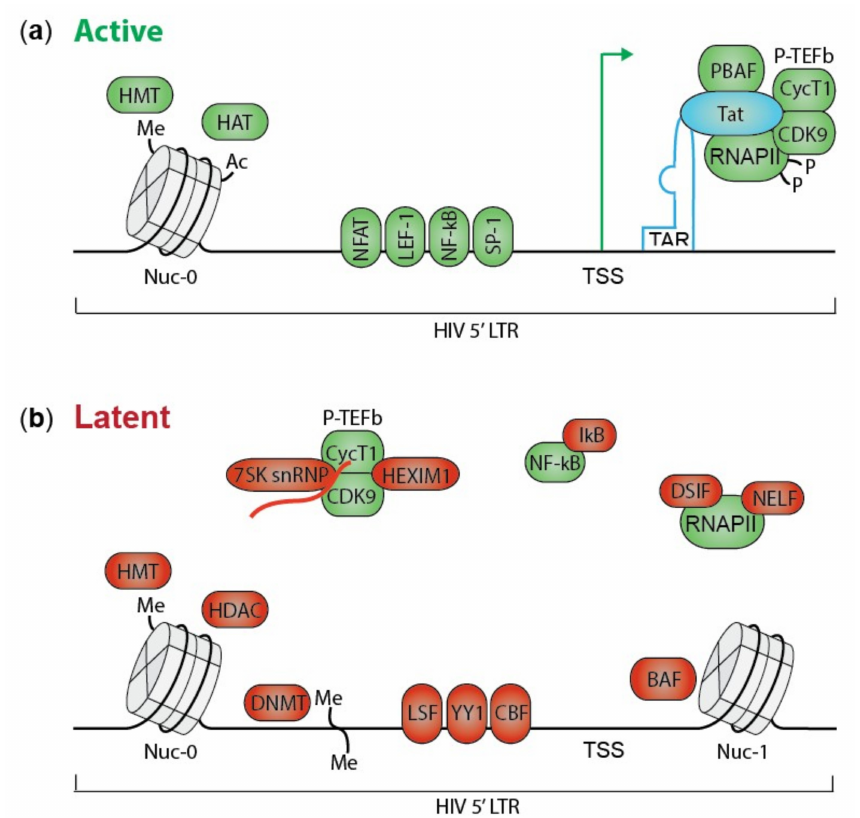
Figure 1. The HIV LTR promoter in active and latent state. ( a ) HIV Tat induces active transcription by binding the TAR RNA element in the LTR promoter and recruiting several transcription activating proteins. P-TEFb releases and activates RNAPII by CDK9-mediated phosphorylation. PBAF ensures open nucleosome-free chromatin. NF- κ B and other transcription factors as NFAT, LEF-1 and SP-1 bind to the HIV LTR. An active chromatin landscape is maintained by histone methyl transferases (HMT) and histone acetyl transferases (HAT). ( b ) In latent cells, HIV transcription is inhibited by multiple mechanisms. Several proteins required for e ff ective transcription are sequestered in an inactive state. For instance RNAPII is sequestered by DSIF and NELF, NF- κ B by I κ B, and P-TEFb by 7SK snRNP and HEXIM1. Furthermore, transcriptional repressors as LSF, YY1 and CBF bind the LTR promoter. A repressive chromatin landscape is formed by HMT, histone deacetylases (HDAC) and DNA methyl transferases (DNMT). Finally, BAF positions Nuc-1 downstream of the TSS, inhibiting transcription elongation. Tat; transactivator of transcription, TAR; transactivation response RNA, P-TEFb; positive transcription elongation factor b, RNAPII; RNA polymerase II, CDK9; cyclin dependent kinase 9, PBAF; polybromo-associated BAF, NF- κ B; nuclear factor kappa b, NFAT; nuclear factor of activated cells, LEF-1; lymphoid enhancer-binding factor 1, SP-1; specificity protein 1, HMT; histone methyl transferase, HAT; histone acetyl transferase, DSIF; DRB sensitivity inducing factor, NELF; negative elongation factor, I κ B; inhibitors of NF- κ B, 7SK snRNP; 7SK small nuclear RNA, HEXIM-1; Hexamethylene bisacetamide-induced protein, LSF; late SV40 factor, YY1; yin yang 1, CBF; C-promoter binding factor, LTR; long terminal repeat, HDAC; histone deacetylase, DNMT; DNA methyl transferase, BAF; BRG-associated factor, Nuc-1; nucleosome 1, TSS; transcription start site. Green symbols represent factors promoting active transcription, while red symbols are transcriptional